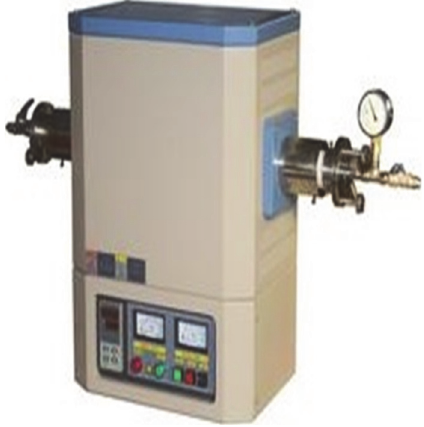
Figure 2: HH-8 digital resistance heating